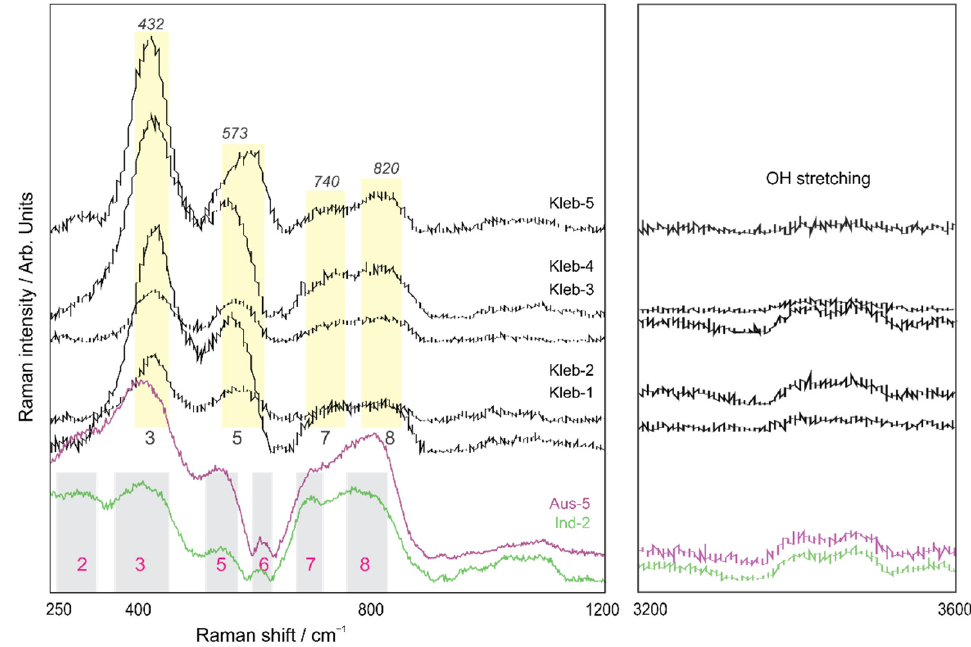
Figure 5. Raman spectrum of kleberite (black) compared to the Raman spectra of South Australian (magenta) and Indonesian (green) pseudorutile.